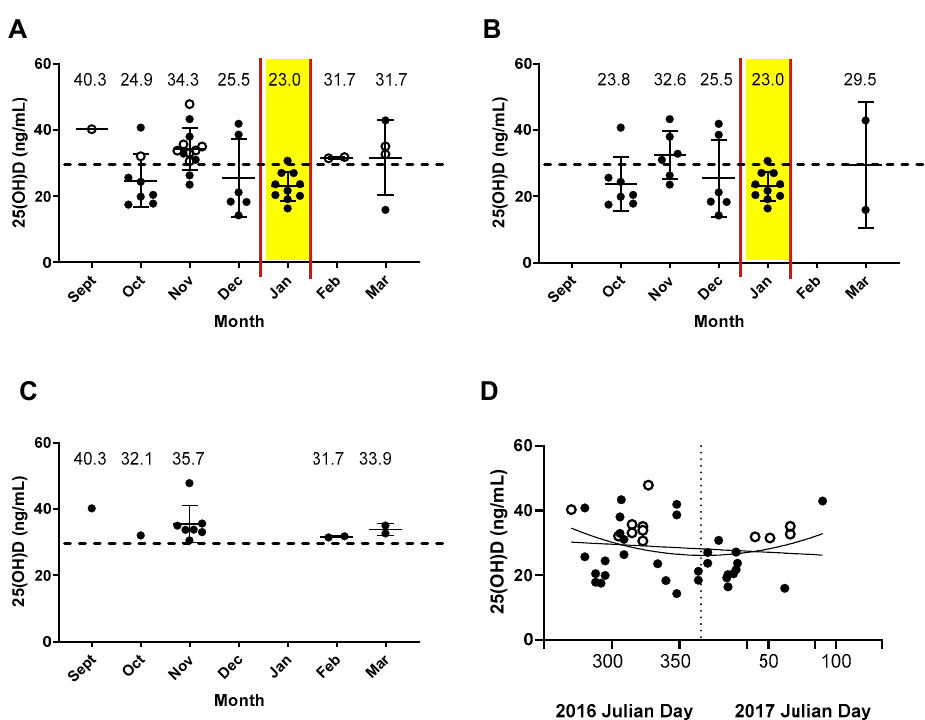
Figure 1. The 25(OH)D levels are shown as categorized by month for ( A ) all study participants (solid and open symbols represent black and white participants, respectively), ( B ) black participants alone, and ( C ) white participants alone. The month with the lowest mean value is highlighted in yellow. Means (also recorded by number above symbols) with standard deviations are shown. ( D ) 25(OH)D levels were plotted against Julian day of the year with solid and open symbols representing black and white participants, respectively. A linear regression line and a quadratic regression curve are shown (R 2 = 0.01, p = 0.44 for the linear regression; R 2 = 0.07 for the quadratic regression).